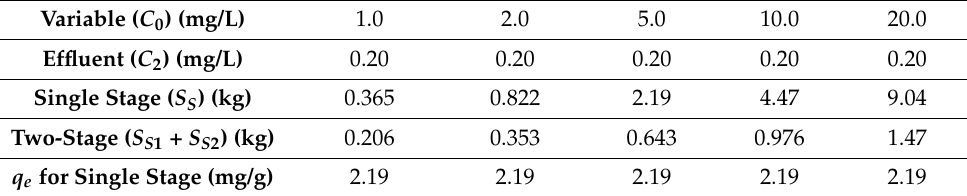
Table 8. Minimum total amount of phosphoric-acid-activated date stone carbon for an IBU effluent concentration of 0.20 mg/L in both a single ( S S ) and two-stage ( S S 1 + S S 2 ) system for various C 0 values for 1000 L